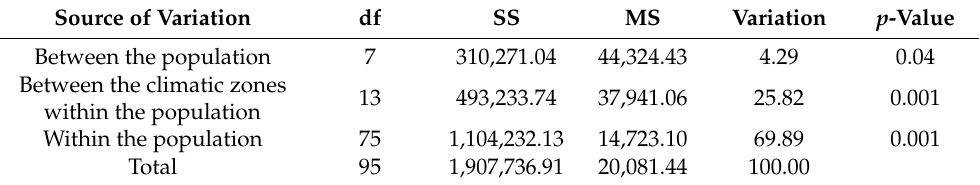
Table 4. Analysis of molecular variance (AMOVA) based on the population and climatic zone as being the sources of the genetic variation.